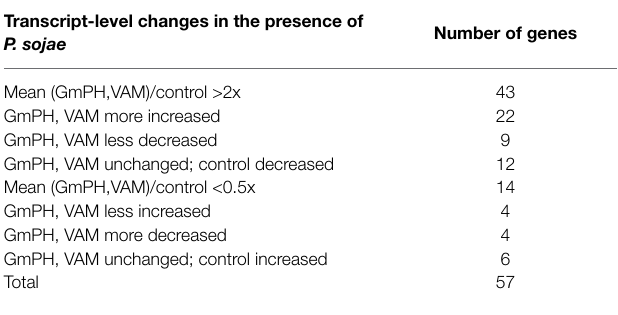
TABLE 2 | Common transcript-level changes in the presence of Phytophthora sojae . Transcript-level changes in the presence of P.